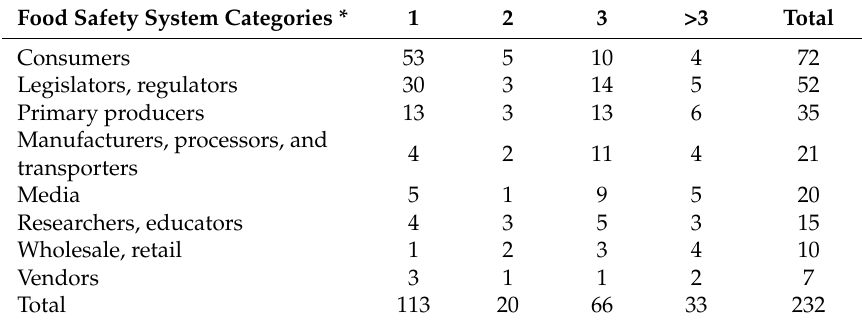
Table 5. Number of articles that mentioned one or more food safety system